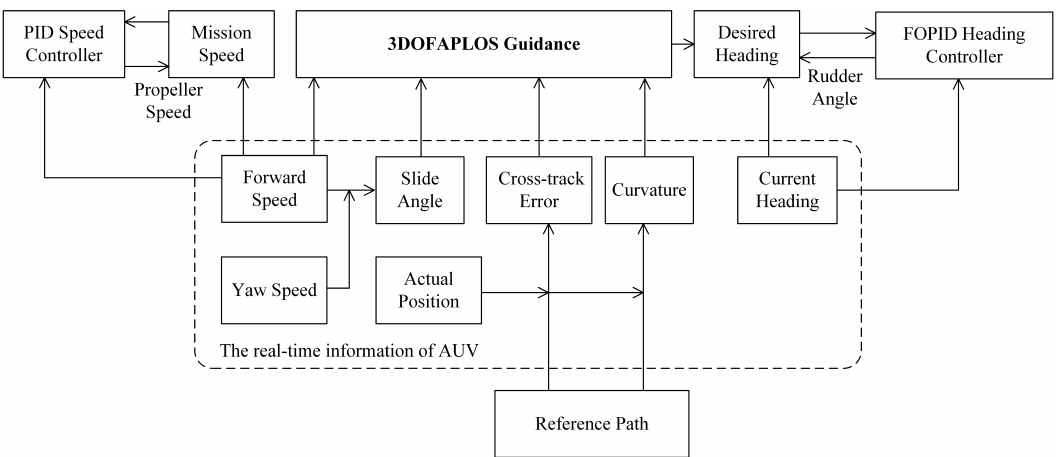
Figure 3. Block diagram of the controller system.